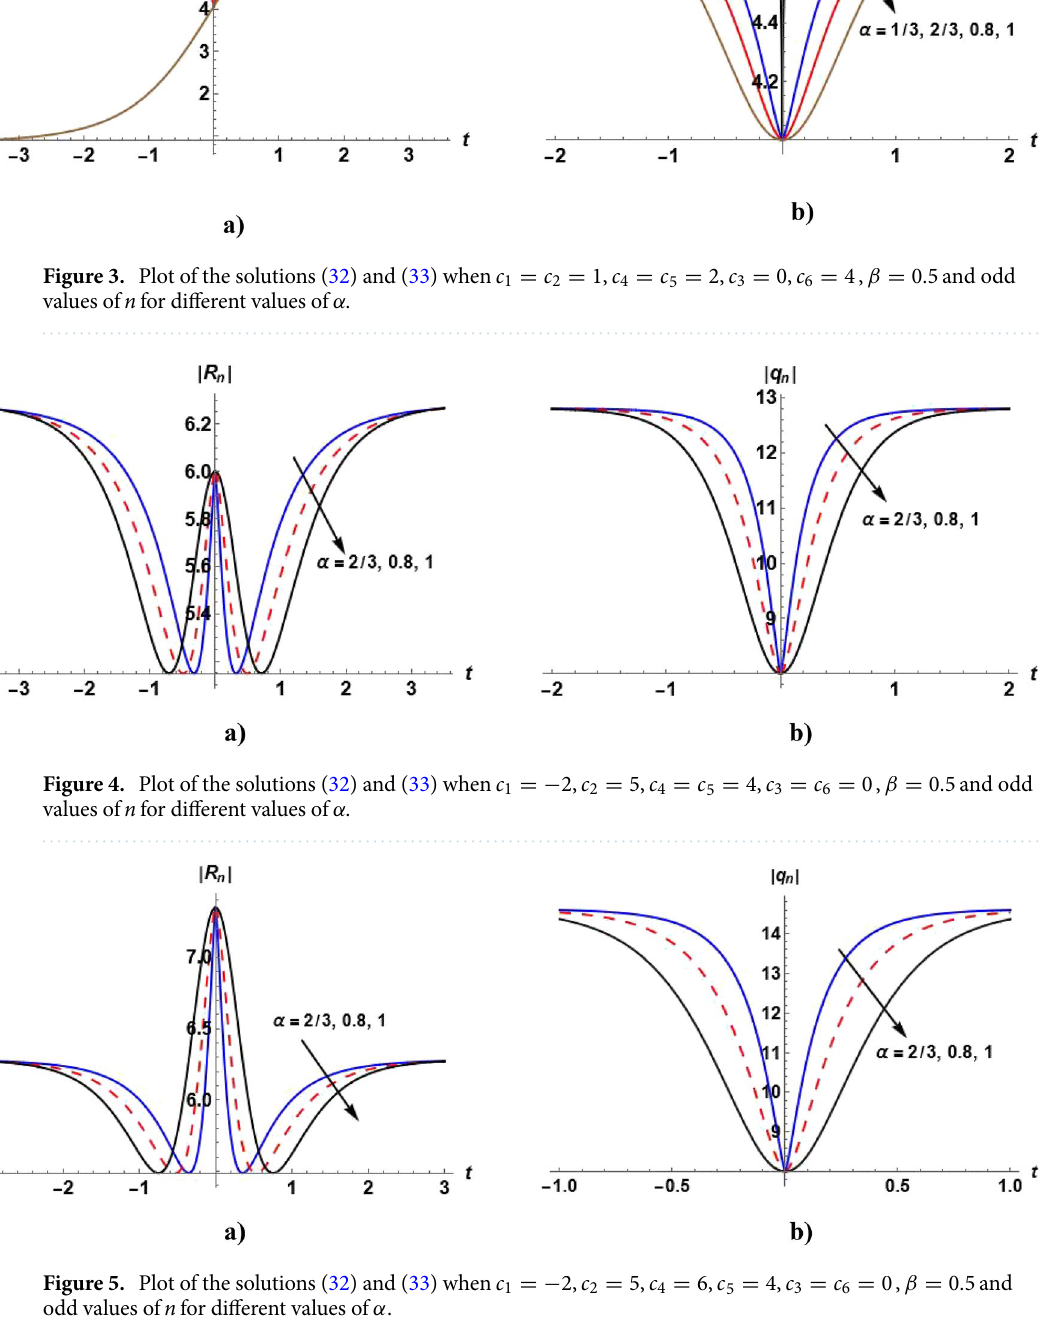
Figure 5. Plot of the solutions (32) and (33) when c 1 odd values of n for different values of α